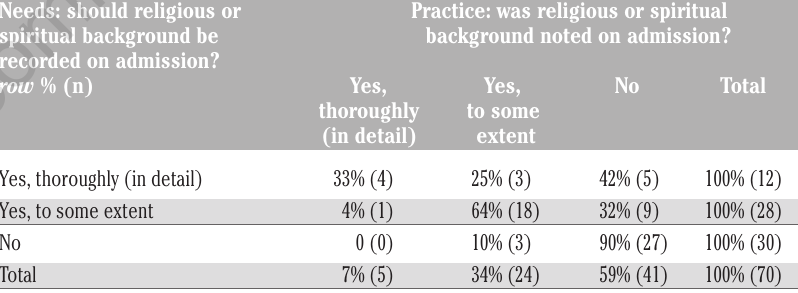
Table 5. Patients’ needs for enquiry (n=70